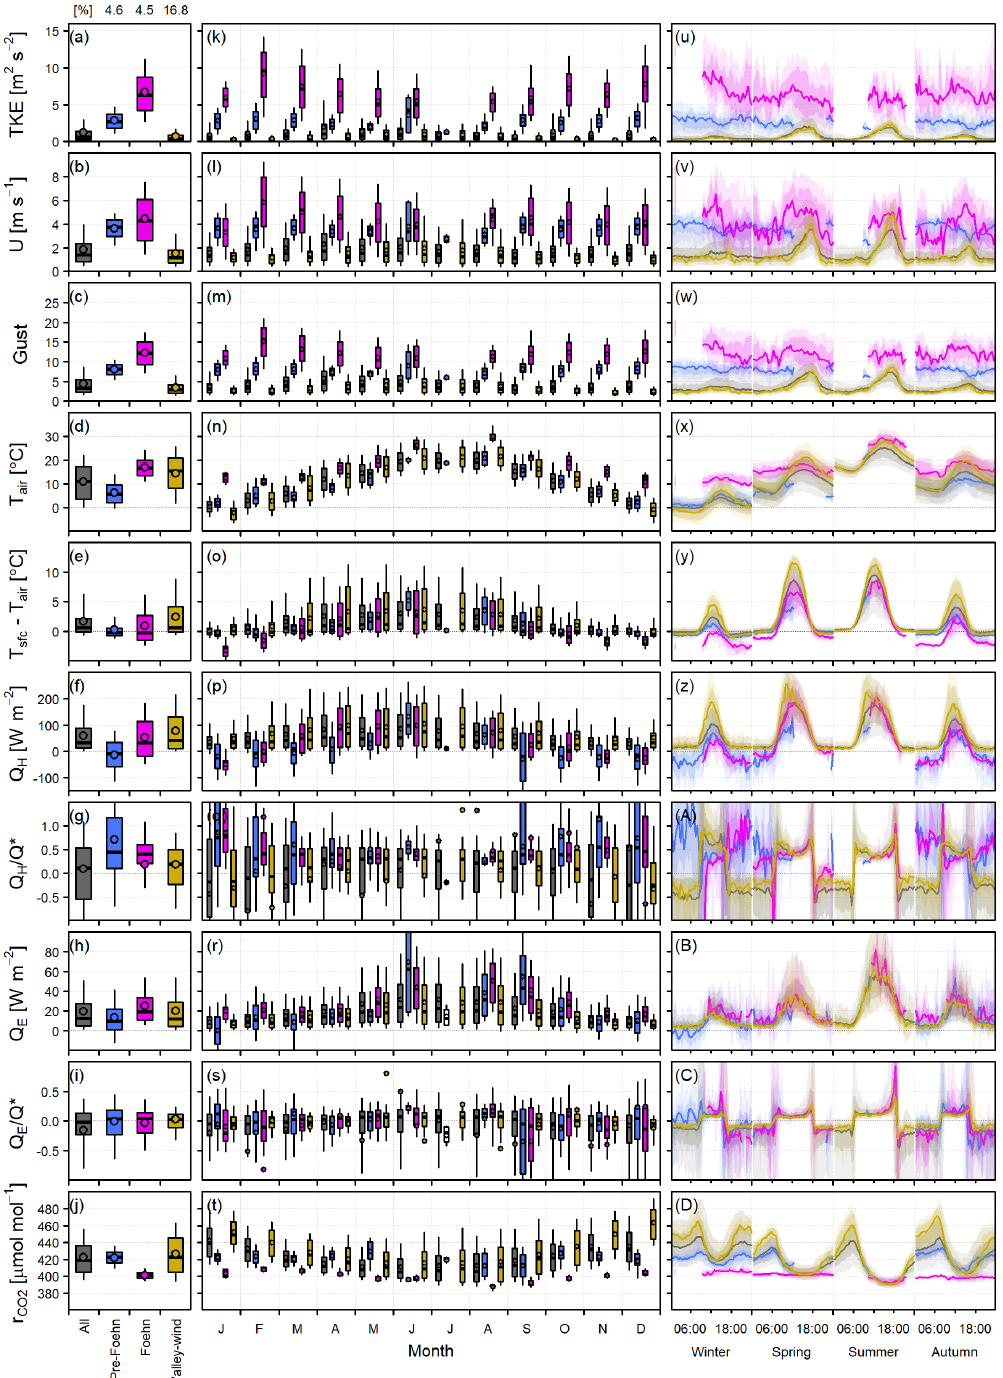
Figure 17. Impact of different flow regimes (colours) on (a, k, u) turbulent kinetic energy, (b, l, v) wind speed, (c, m, w) gust speed, (d, n, x) air temperature, (e, o, y) the difference between surface and air temperature, (f, p, z) sensible heat flux, (g, q, A) sensible heat flux ratio, (h, r, B) latent heat flux, (I ,s, C) latent heat flux ratio and (j, t, D) CO 2 mixing ratio at IAO. Box plots are shown for all data together (a–j) and for all data separated by month (k–t) . Boxes indicate the interquartile range, whiskers the 10–90th percentiles and the median and mean are shown by horizontal bars and points, respectively. Median diurnal cycles (lines), interquartile ranges (dark shading) and 10–90th percentiles (light shading) are separated by season (u–D) . The category “All” refers to the whole dataset (i.e. includes the other categories), and the proportion of the study period classified as each of the other categories is given above (a) . Data are plotted if more than five data points are